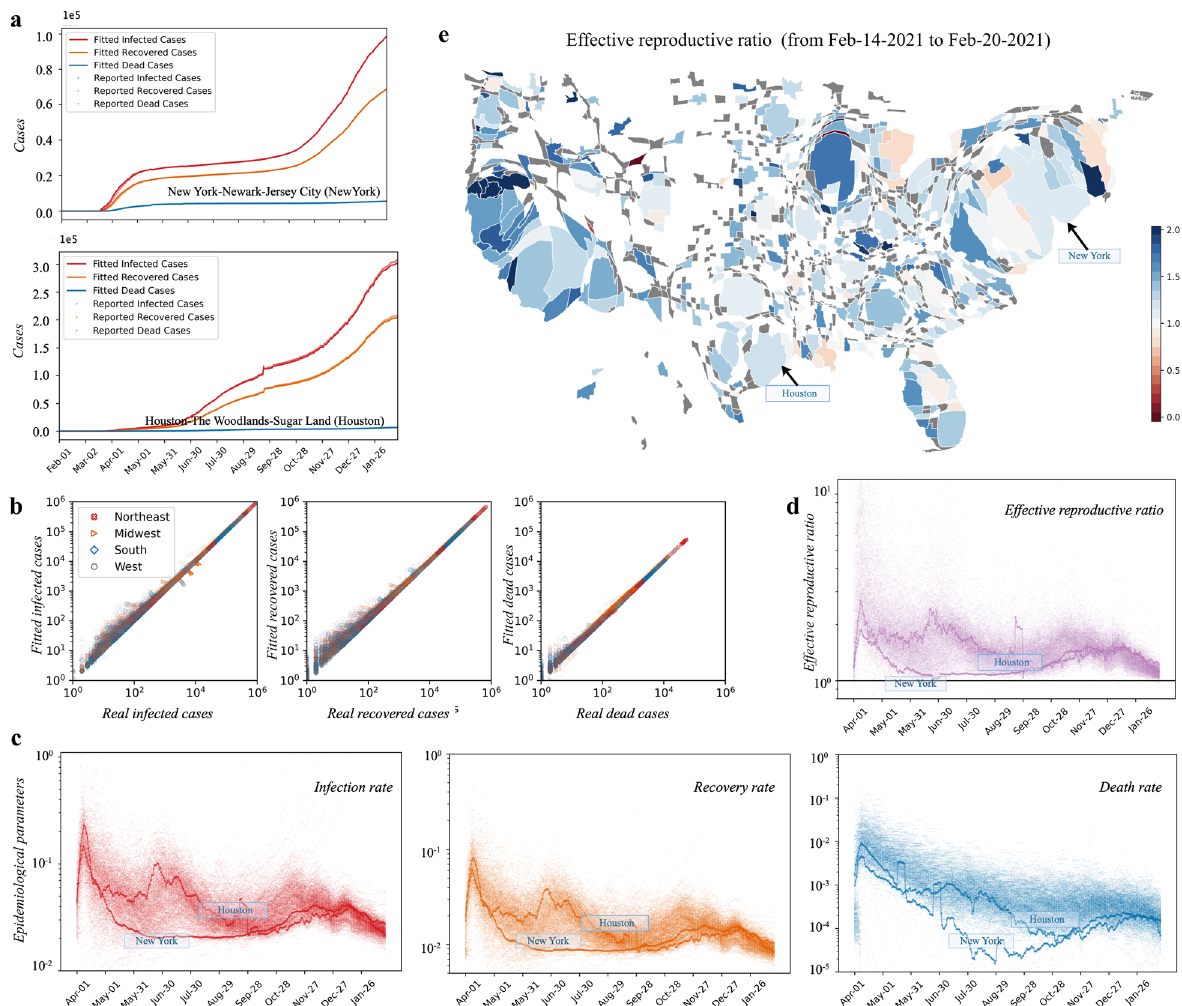
Fig. 2 The designed feedback controllers U Θ drive the output trajectories (_ X ) in the SIRD model ingeniously fi ts the reported trajectories (_ X d ) for 381 MSAs. a The reported data (dots) of infected/recovered/dead cases are fi tted with the output trajectory (solid line) for example MSAs, i.e., “ New York ” MSA and “ Houston ” MSA. b Comparison between the reported data and output data at all MSAs. Each MSA represent a dot. c All MSAs' temporal infection rate, [ β 0 + U β ( t )], recovery rate, [ γ 0 + U γ ( t )], and death rate, [ δ 0 + U δ ( t )] with marking out the examples MSAs' rates. d shows the MSA ’ s temporal effective reproductive ratio ( R e ) and e shows each MSA ’ s average effective reproductive ratio from 14 February 2020 to 20 February 2021 in the cartogram map, in which the geometry of regions is distorted according to their population. The effective reproductive ratio reaches the lowest as of 20 February